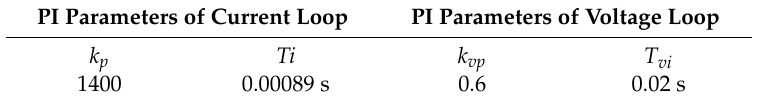
Table 2. Parameters of the controller.